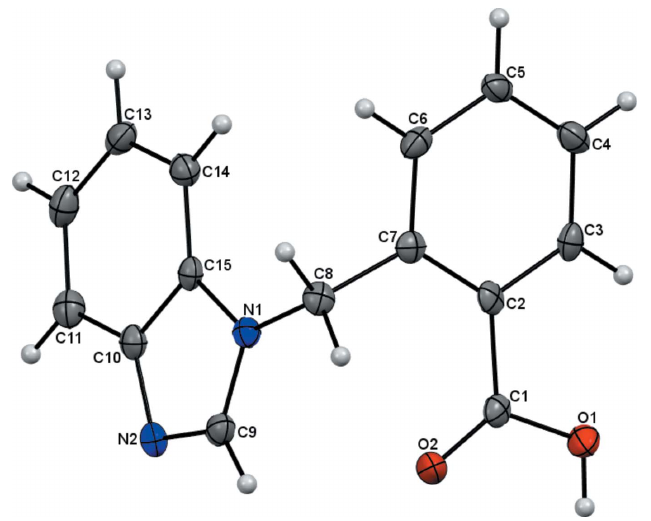
Figure 1 Asymmetric unit of title compound, with atom labelling and displacement ellipsoids are drawn at the 50% probability